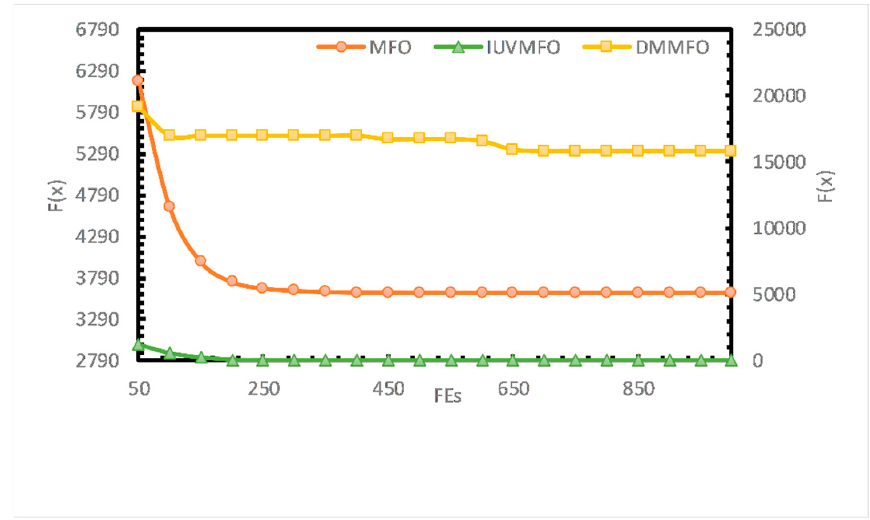
Energies 2022 , 15 , x FOR PEER REVIEW Figure 9. The result curve of F22. Figure 9. The result curve of F22.